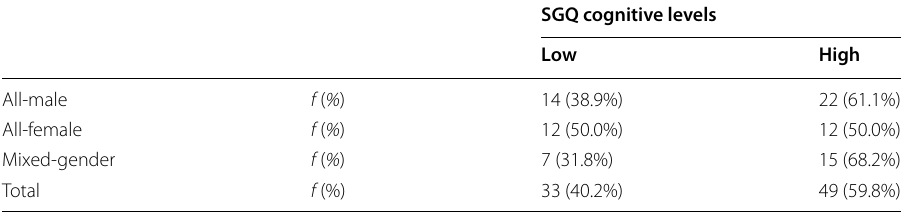
Table 4 The cognitive levels of SGQ by gender group composition ( n